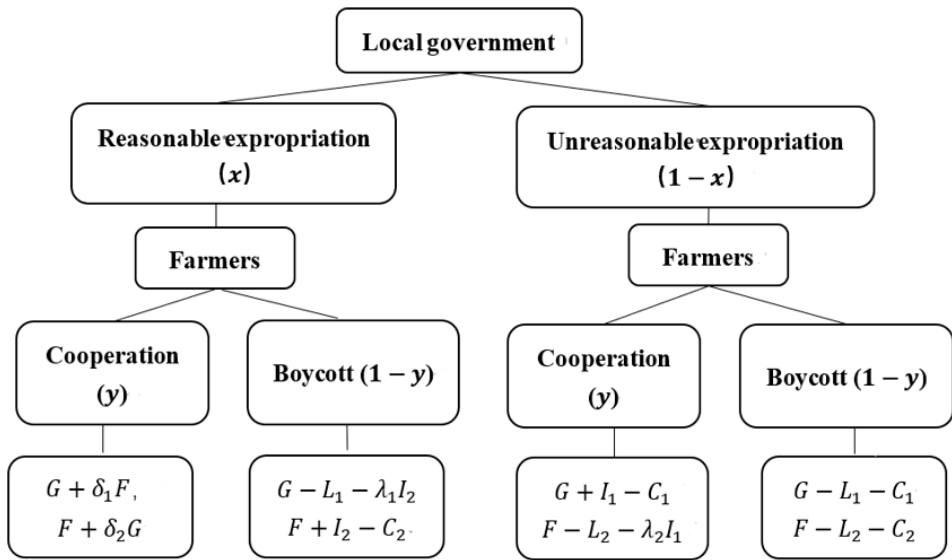
Figure 2. Dynamic game payment matrix of land expropriation conflict under reciprocal altruism preference and loss aversion